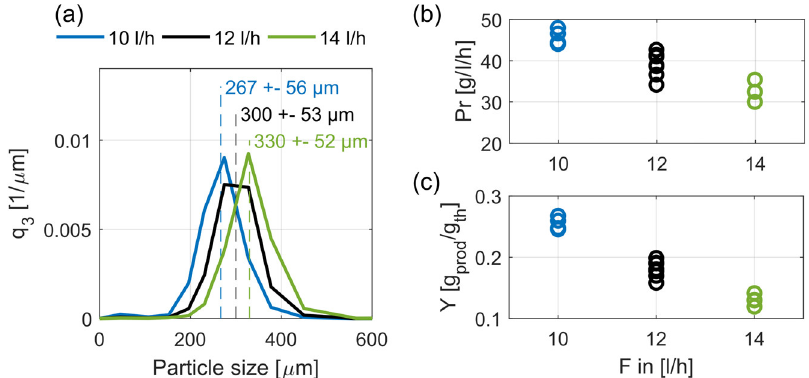
Figure 8. Mean steady-state crystal size distributions, q 3 , with their respective mean values and standard deviations ( a ), productivities, Pr ( b ), and yields, Y ( c ), for three different volumetric flowrates, F = 10, 12, and 14 L/h. Given results are from crystallizer C2 for Exps. 4 and 5.